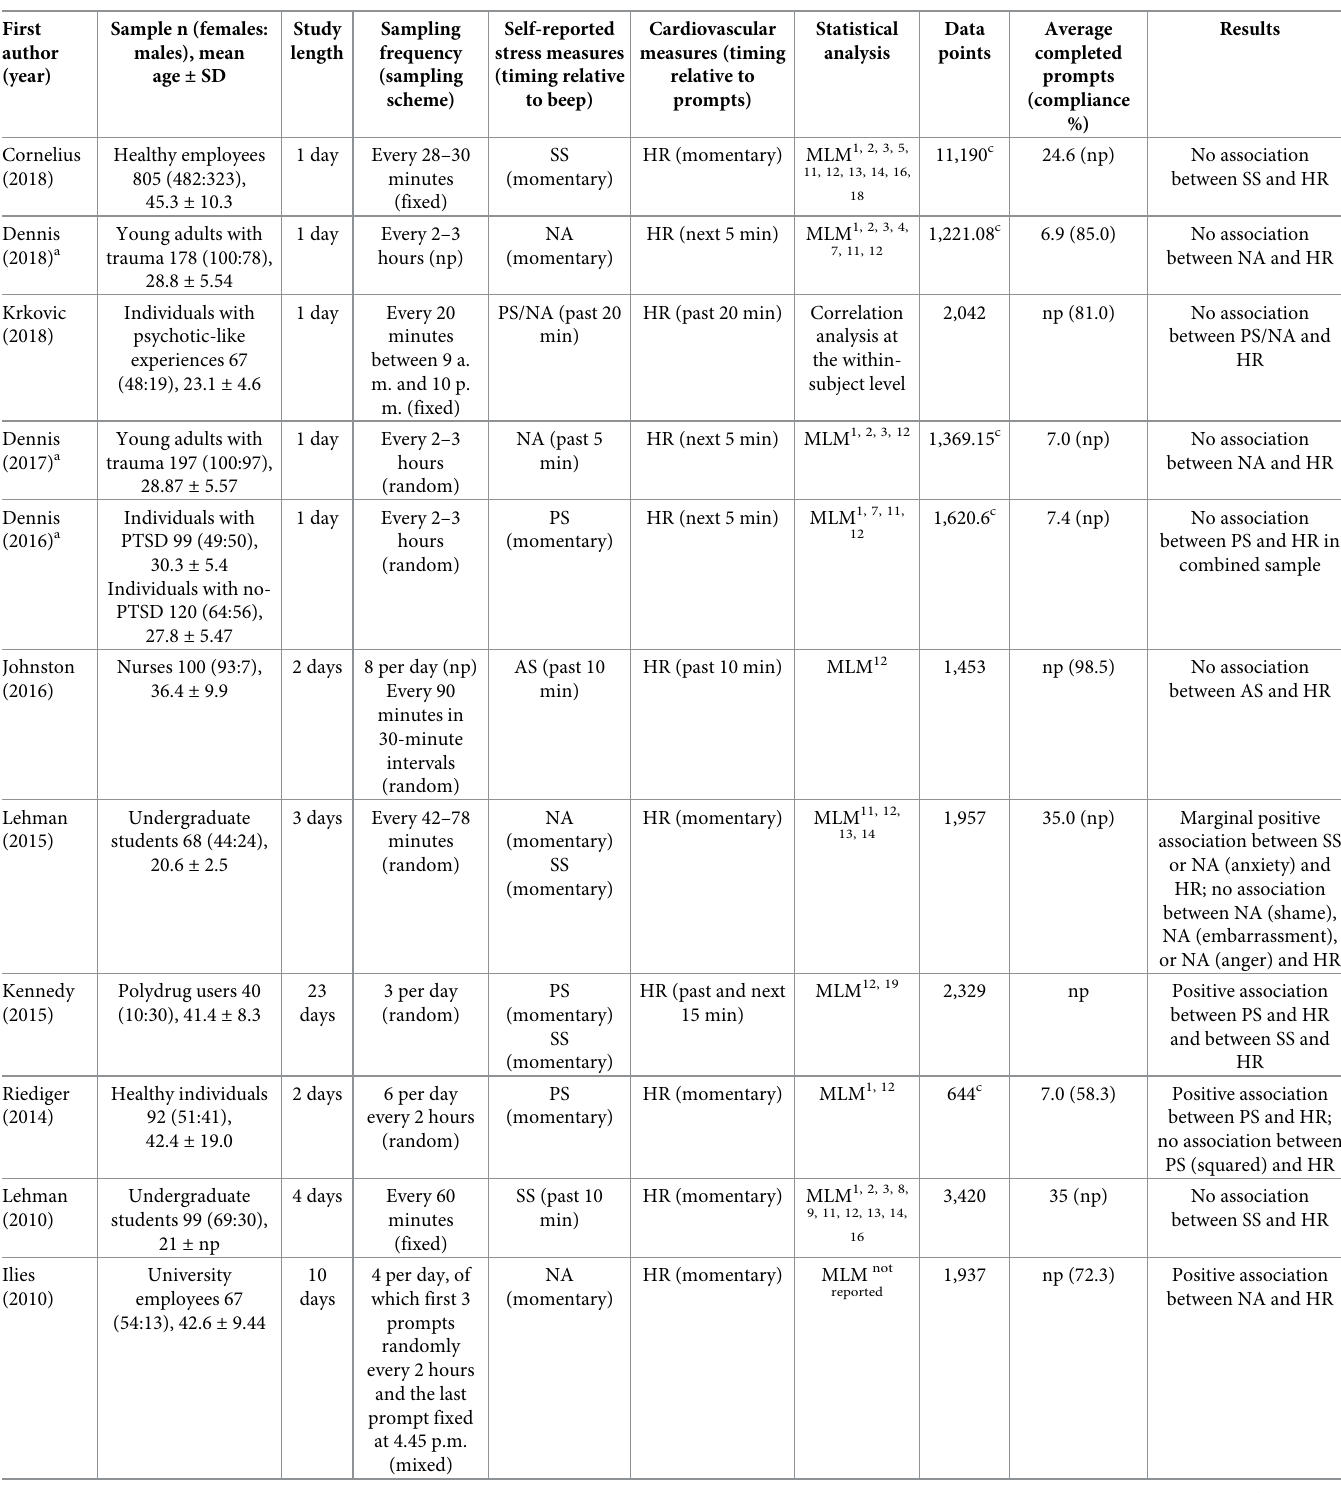
Table 3. Associations with heart